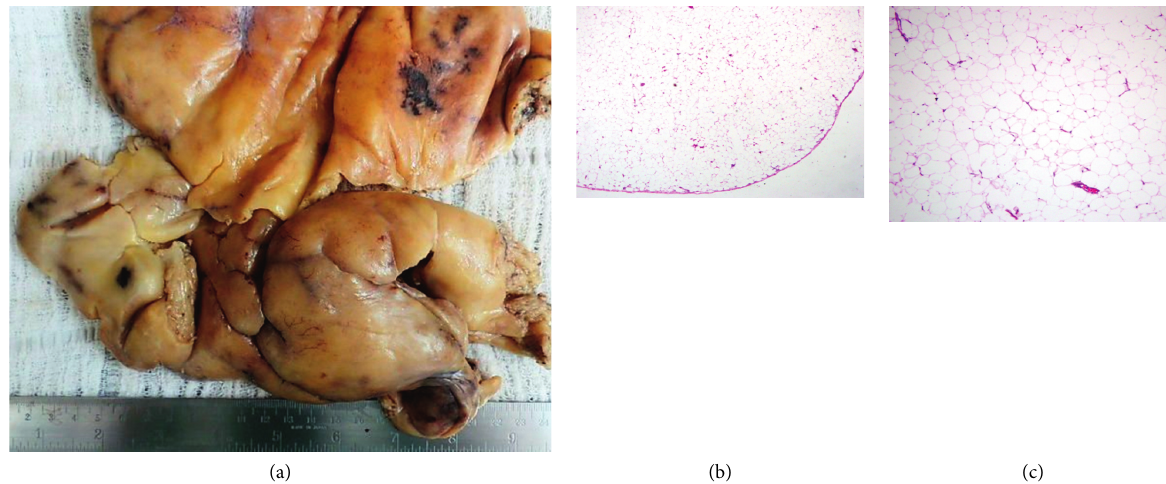
Figure 2: Voluminous intrapericardial lipoma. (a) Gross examination—fatty lobulated massive tumor covered by a fine fibrous capsule. (b) Microscopy—delicate fibrous capsule delineates the mass. (c) Mature adipocytes form the tumor. No atypia is